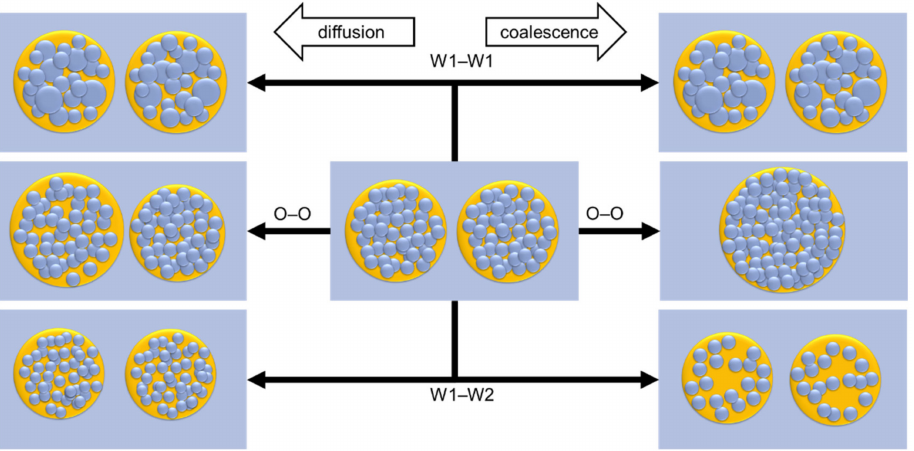
Figure 2. Mass transfer in double emulsions. In the center, the stable emulsion is shown. To the left, the changes due to di ff usion are shown, and to the right, changes through coalescence are depicted. The scheme in accordance with other authors